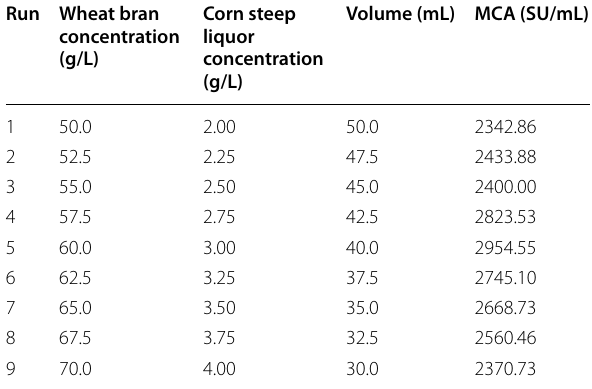
Table 3 The path of steepest ascent/descent